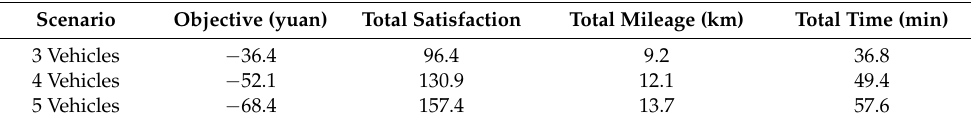
Table 5. Comparison of model and algorithm performance among three scenarios.